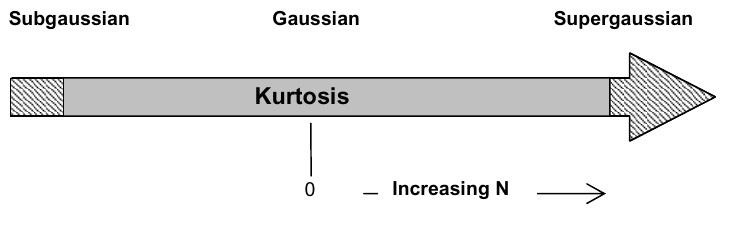
Fig. 8. Kurtosis of a mixture of N damped